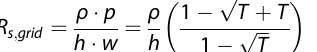
the following equation 35,156 : conductive polymers or oxides, on a metal grid to avoid the disadvantages 157 – 161 . Figure 6a shows a highly transparent